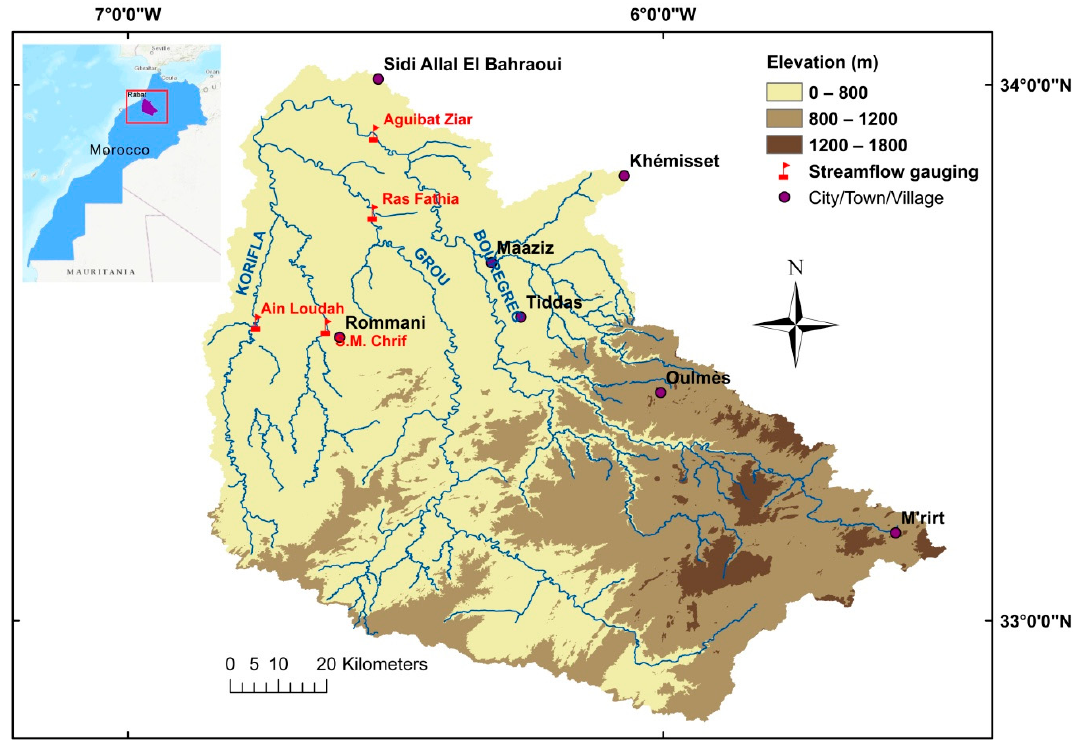
Figure 1. topography, and streamflow network of Bouregreg watershed (BW) and the used gauging stations.